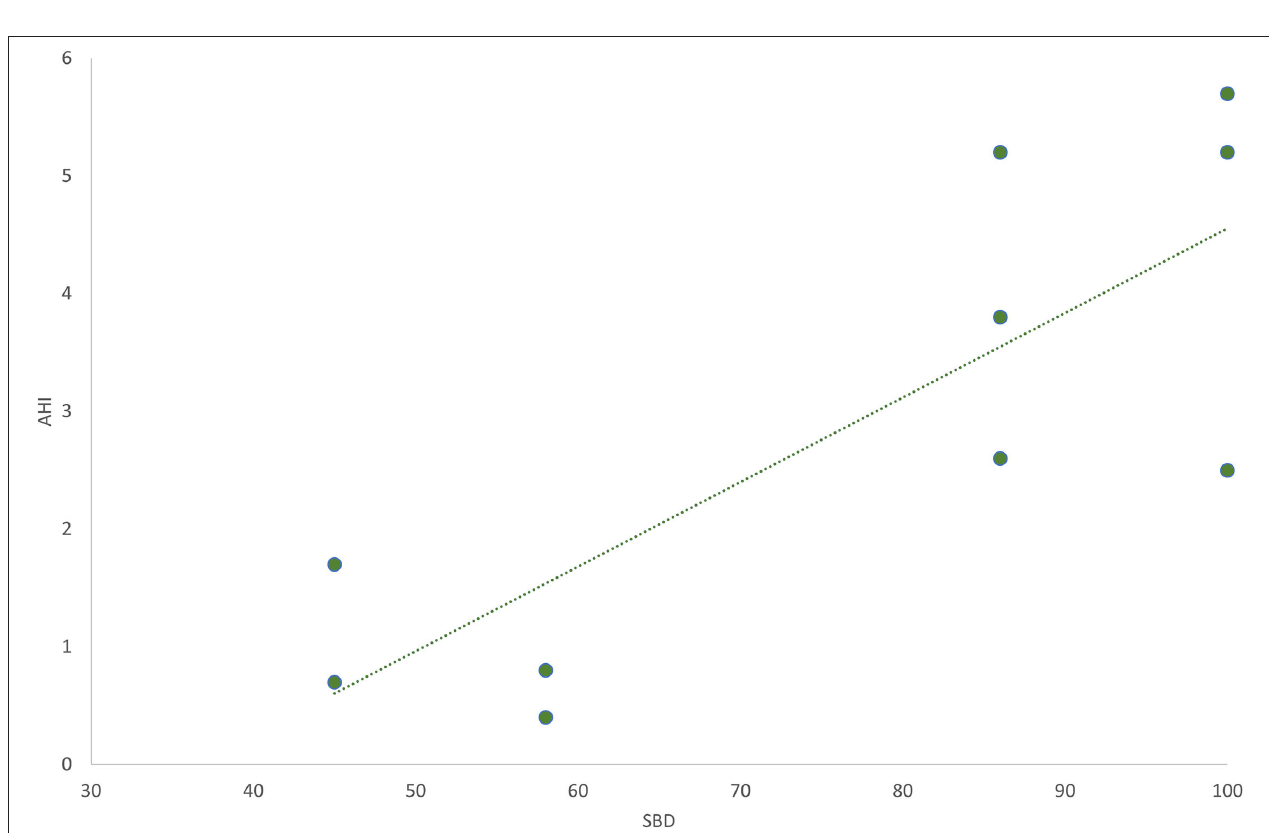
FIGURE 2 | The graphic shows the direct linear correlation between the sleep breathing disorders (SBD) subscale in SDSC test and Apnea-Hypopnea Index (AHI). Pearson’s r = 0.80; p = 0.005.